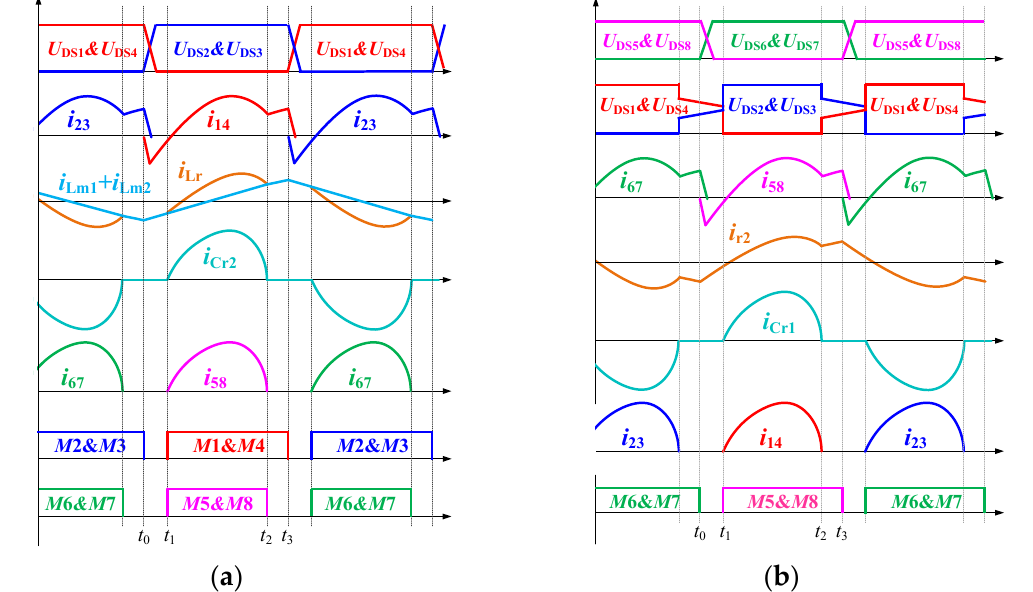
Figure 2. Operation principles of DHC-LT BDC: ( a ) waveforms in step-down mode; ( b ) waveforms in step-up mode.